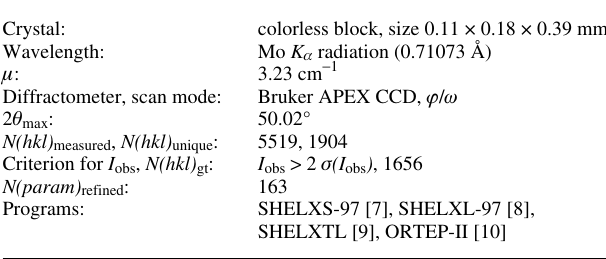
Table 1. Data collection and handling.